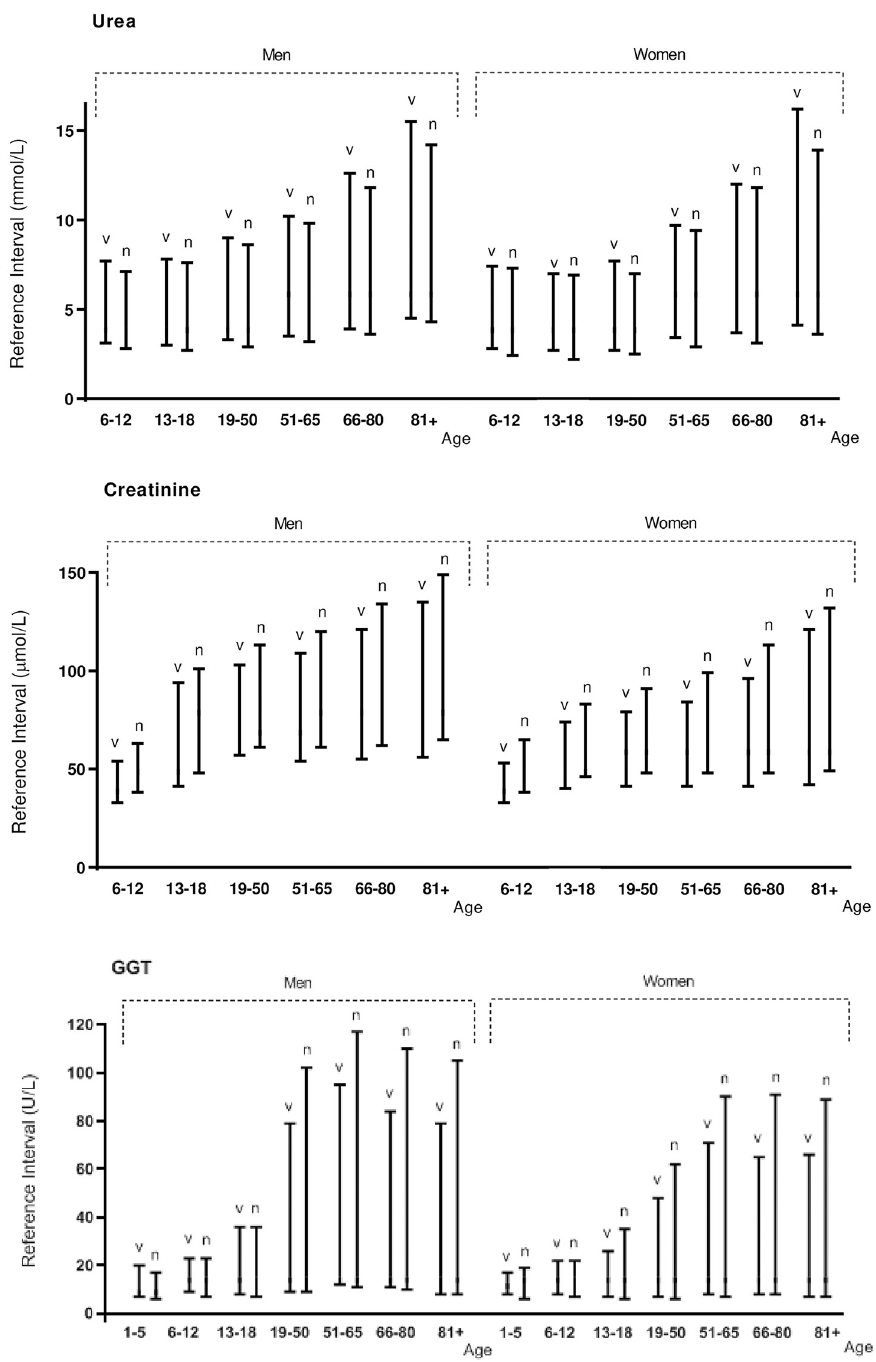
Fig 2. Urea, creatinine and GGT results. Age and sex effects on the reference intervals for creatinine, urea and GGT for Vall d’Hebron (v) and NUMBER (n).